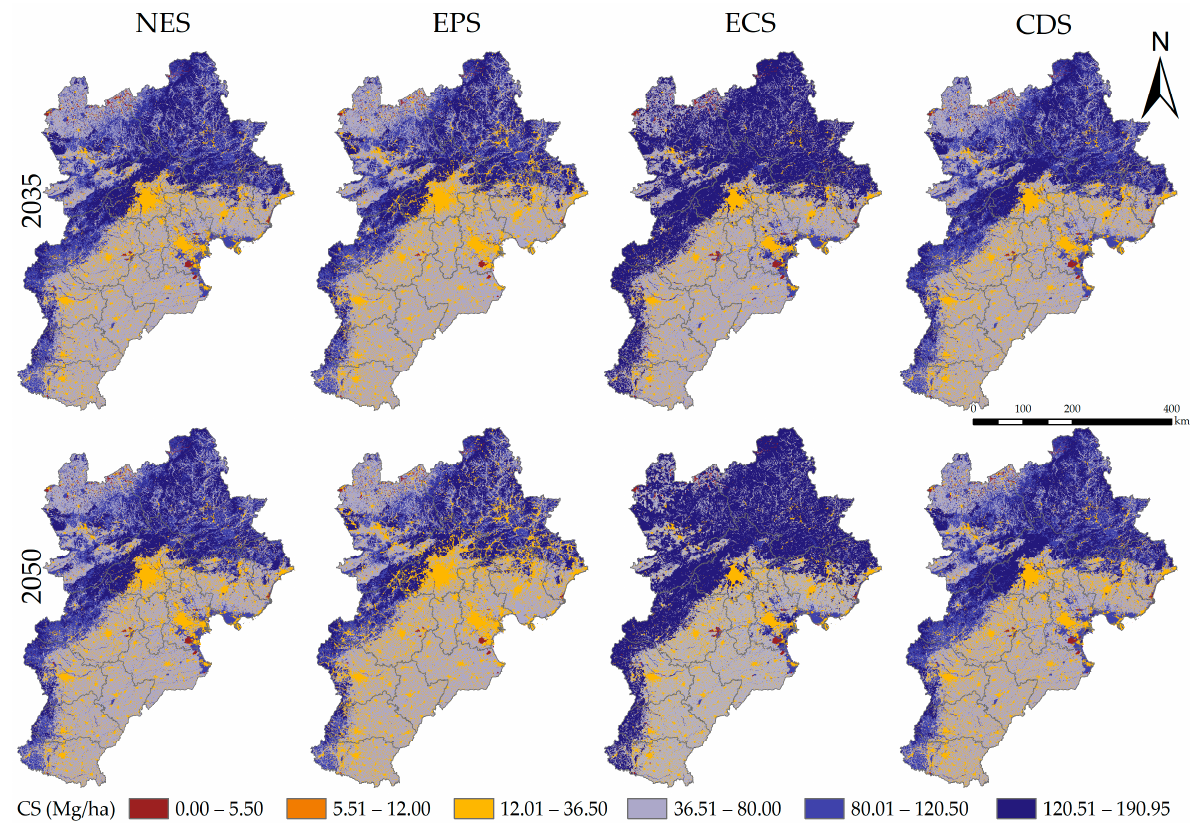
Figure 10. The predicted carbon storage distribution in 2035 and 2050 under four scenarios.